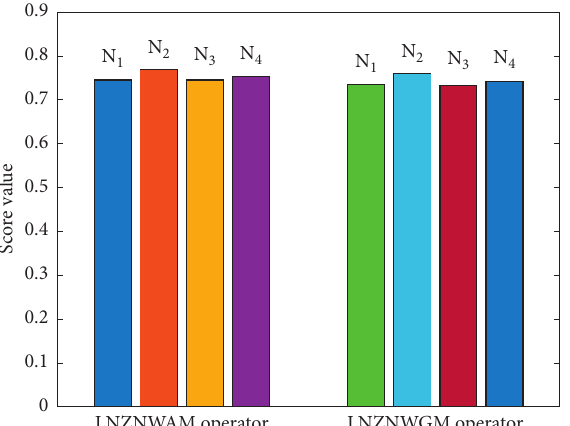
Figure 1: Sorting orders of the four alternatives regarding the developed MAGDM approach using the LNZNWAM and LNNWGM operators. Table 1: Decision results of different MAGDM methods. MAGDM method Score value Sorting order The best